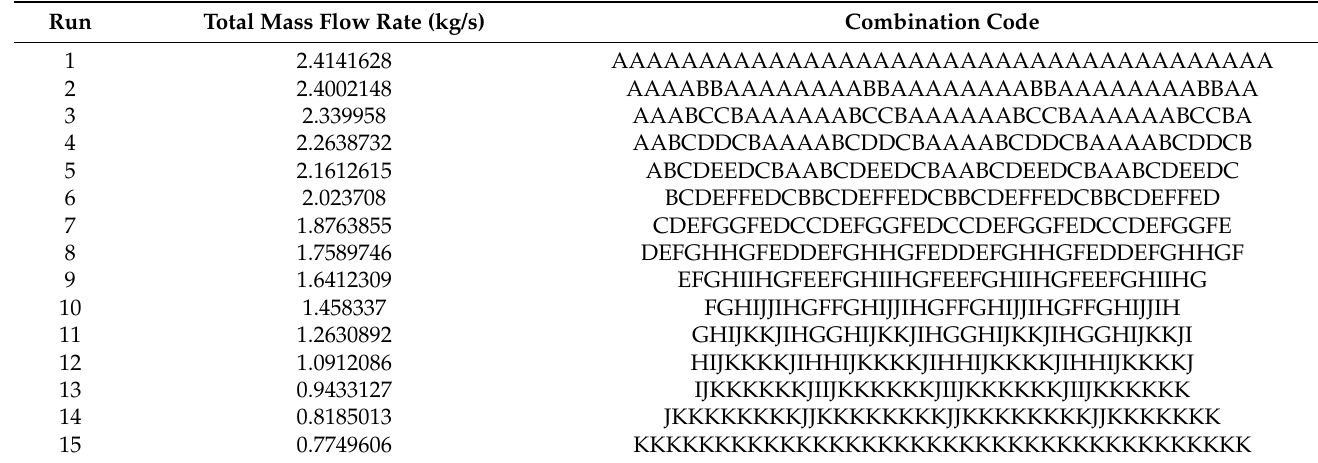
Table 5. Combinations of mass flow rates for four stall cells.